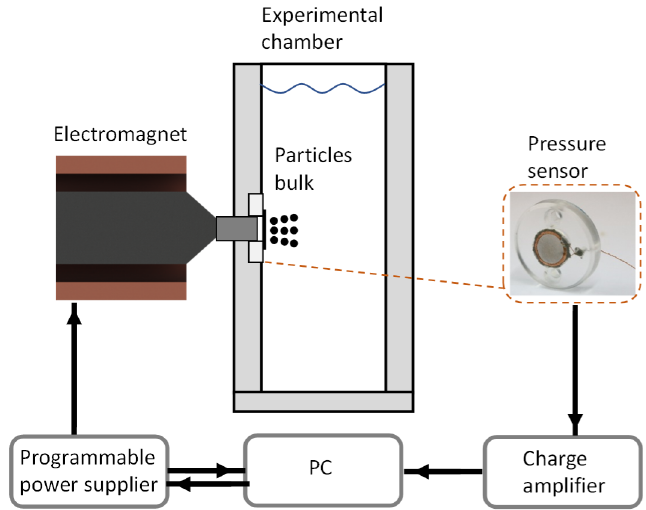
Figure 1. Illustration of experimental system.